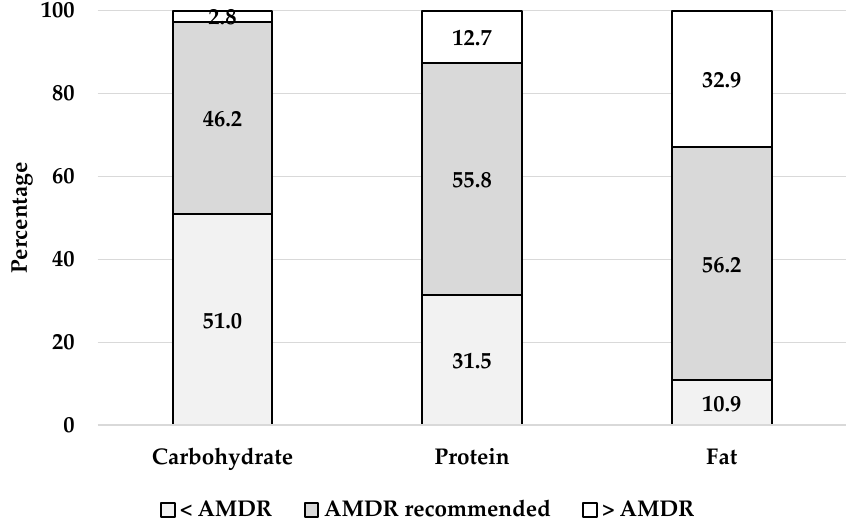
Figure 2. Percentage of daily energy from macronutrients in all reproductive age women ( n = 2323). Acceptable macronutrient distribution range (AMDR) for carbohydrate (45–65%), protein (15–25%) and fat (20–35%). Table 4. Dietary Guideline Index (DGI) and its components, by age groups ( n =